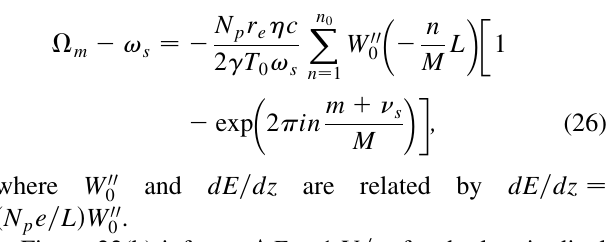
Figure 22(b) informs (cid:4) E (cid:13) 1 V = m for the longitudinal (cid:1) 1 : 5 and a reflection of 2 ; max (cid:1) 10 (cid:5) during 0–6 nsec. The fastest displacement of z z 0 (cid:3) was 10 s (cid:5) 1 in a calculation for growth rate Imag (cid:2) (cid:1) m